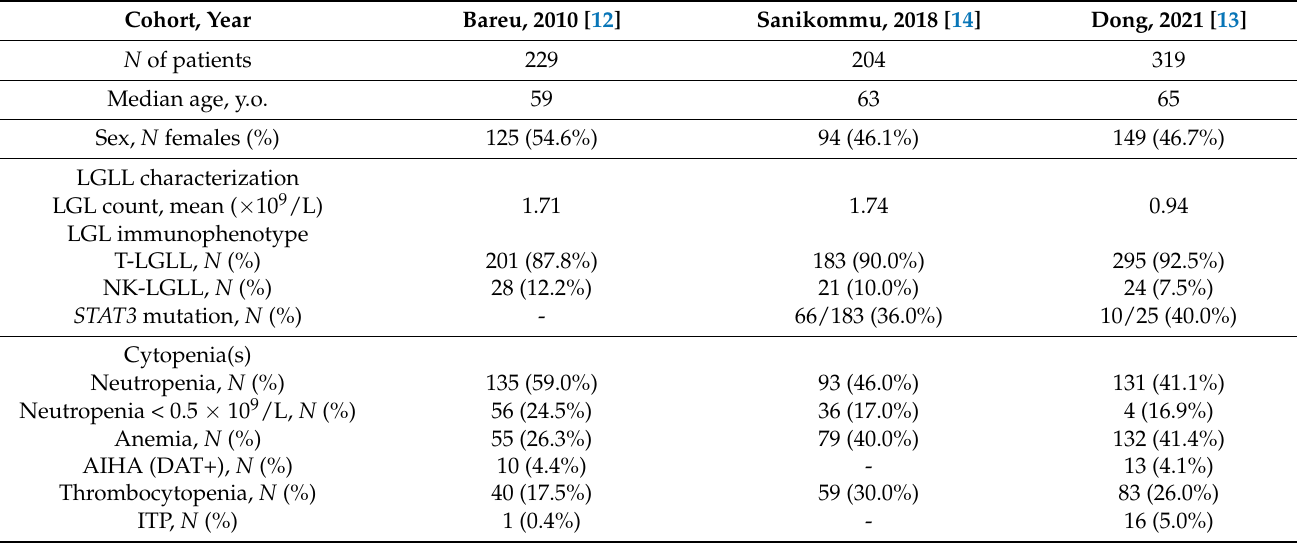
Table 1. Clinical and laboratory characteristics of three main LGLL cohorts ( N >